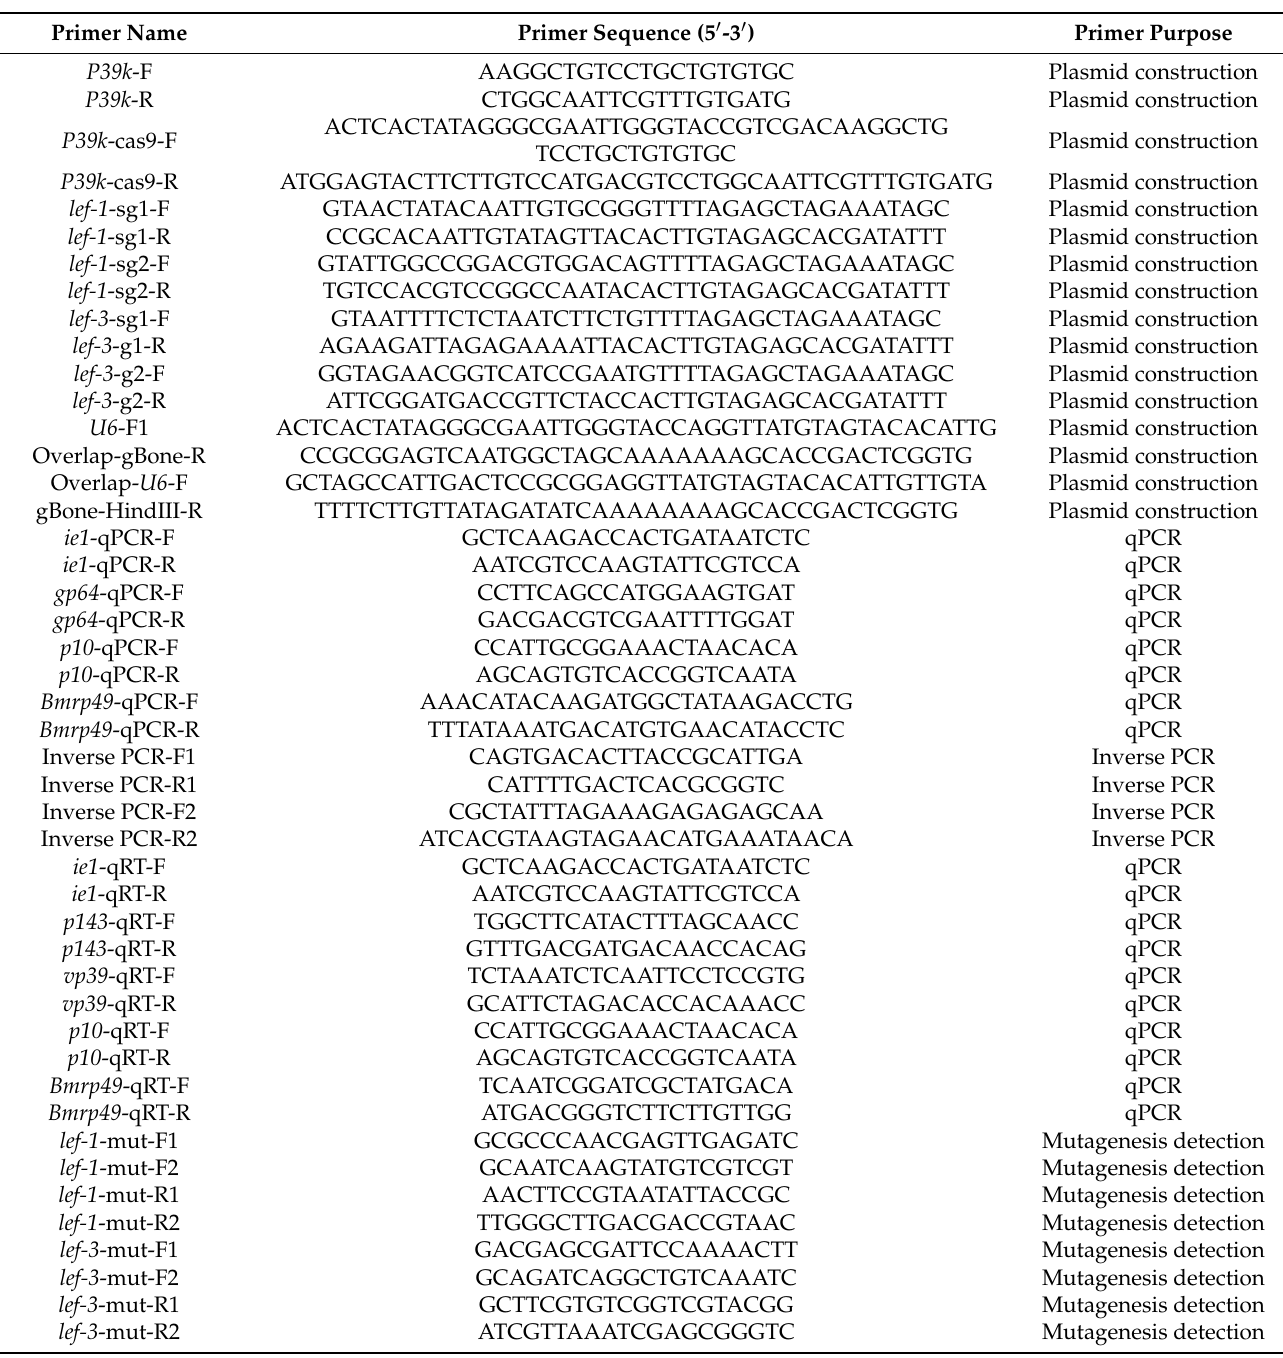
Table 1. Primers used in this